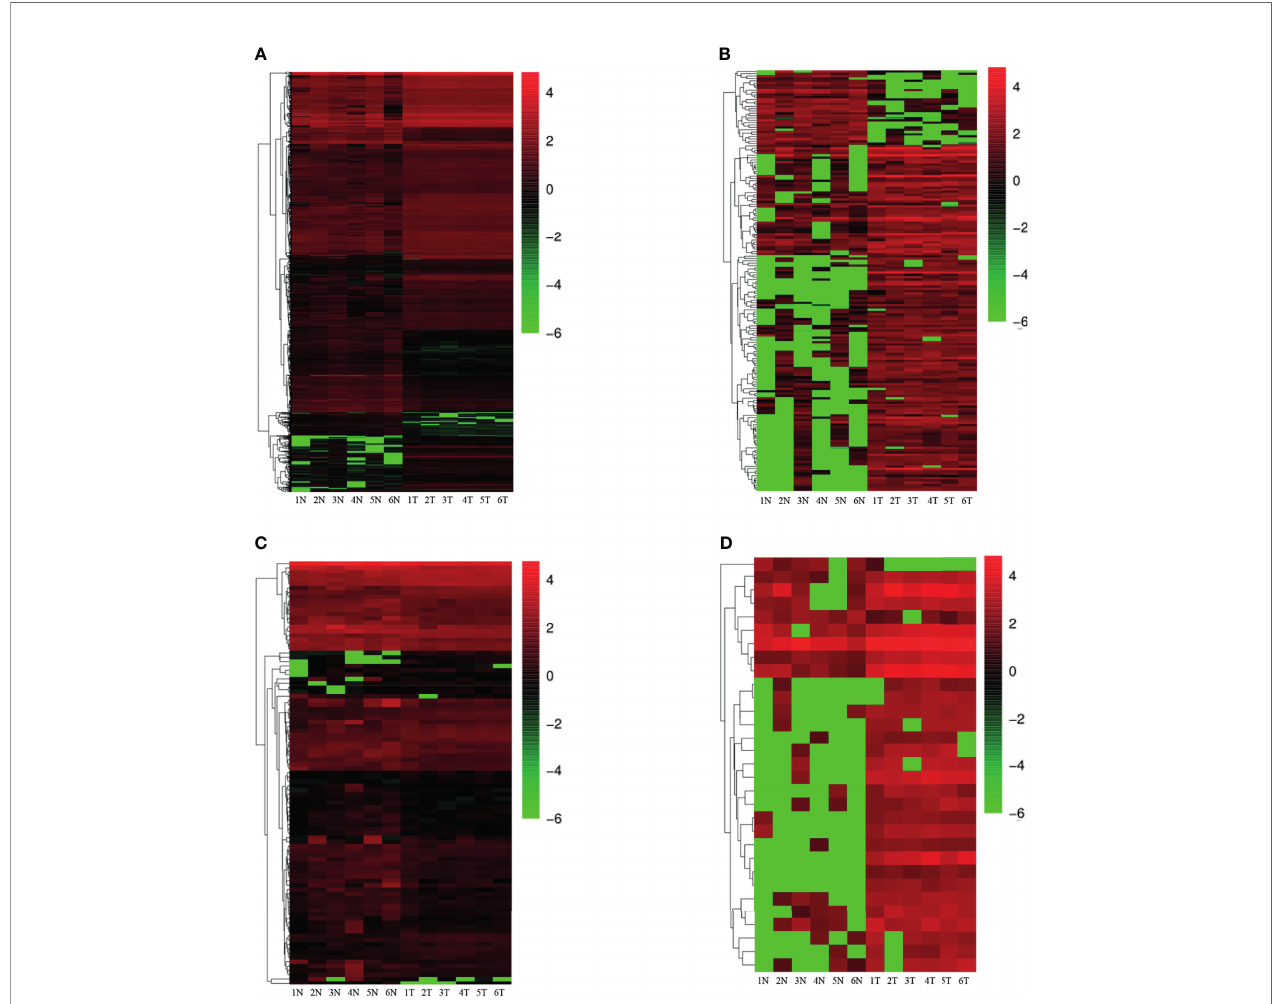
FIGURE 1 | Heatmap of differential expression (N, Normal; T, Tumor) (A) differentially expressed mRNAs; (B) differentially expressed lncRNAs; (C) differentially expressed miRNAs; (D) differentially expressed circRNAs. Red indicates up-regulation and green indicates down-regulation.